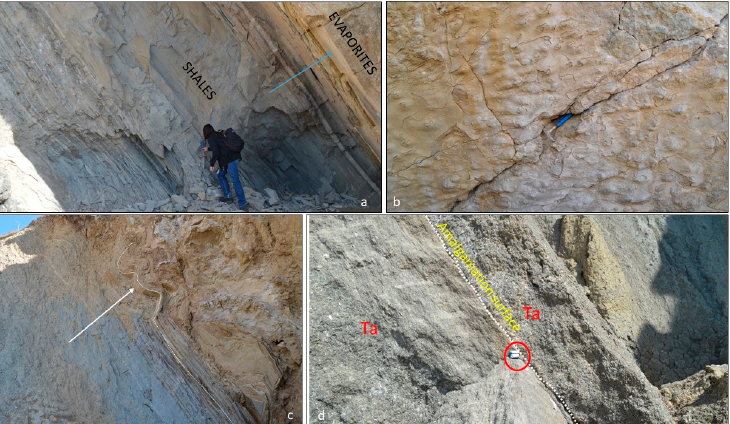
Figure 8. ( a ) Thinly bedded shales between turbiditic evaporites. Arrow shows b, the base of evaporites. ( b ) Evaporites at their base formed structures like load-casts. ( c ) On the top of shales, there are strong deformed shales (white arrow) and this deformation gradually finished. ( d ) Cycles internally to the evaporites; white line marks the contact between cycles, which probably represents an amalgamation surface between Ta Bouma sub-divisions.